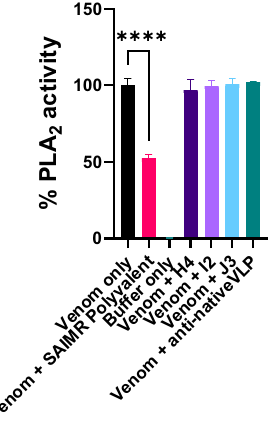
Figure 4. Assays to measure neutralisation of venom PLA 2 activity by anti-veVLP IgG. The PLA 2 activity of Naja nigricollis venom and inhibitory effects of pre-incubation with SAIMR Polyvalent antivenom or IgG raised against veVLP PLA 2 epitopes on PLA 2 activity was measured using the EnzCheck PLA 2 Assay Kit. Data shows the mean of duplicate repeats and error bars represent standard deviation. The relative fluorescent units (RFU) were translated into % activity, where the mean RFU for venom only represents 100% activity, and Buffer only (no venom) represents 0% activity. The effect of antivenom or test IgG was determined by calculating the remaining activity as a percentage of the venom only controls. One-way ANOVA tests were performed to determine statistically significant results. **** indicates p <